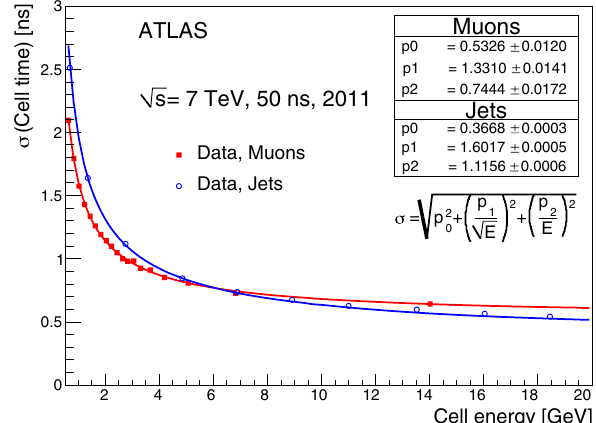
Fig. 28 Cell time resolution as a function of cell energy associated with jets and muons from 2011 collision data. The data are fit to Eq. (7), with the fit results for the three constants shown within the figure. The parameters p 1 and p 2 corresponds to energy expressed in GeV. Sta- tistical errors are included on the points and on the fit parameters. The statistical uncertainties are smaller than the markers identifying the data points